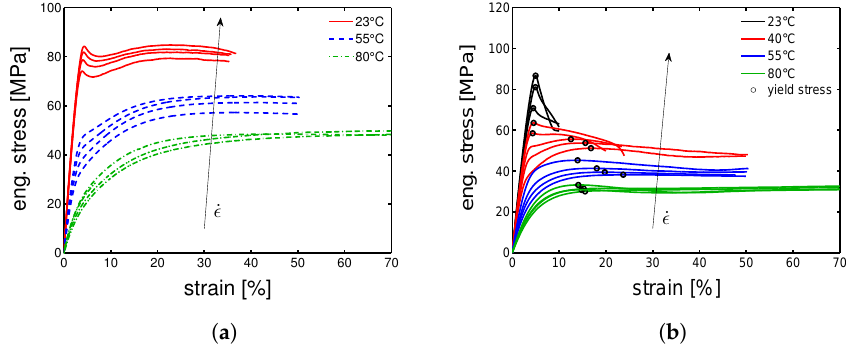
Figure 4. Stress-strain response at different temperatures and a range of strain rates for ( a ) α -I and ( b ) γ -I samples.